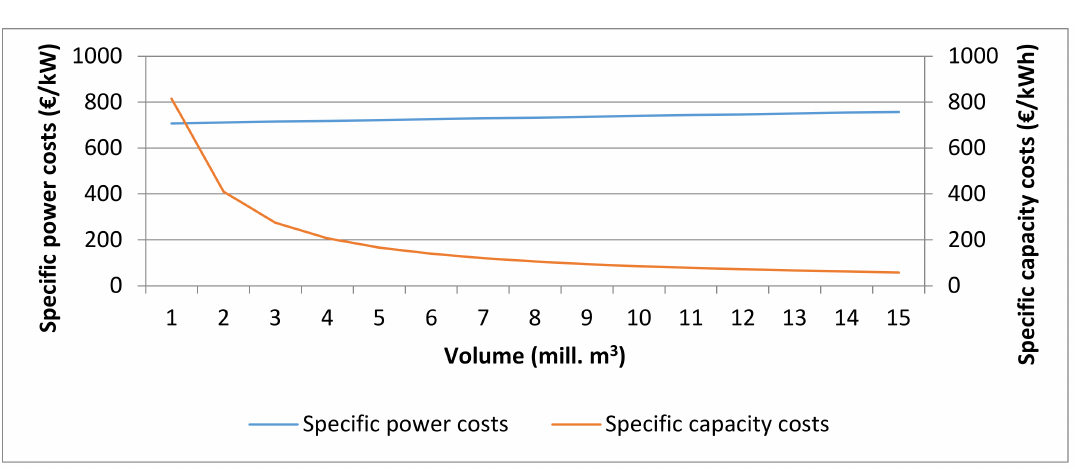
Figure 5. Specific investment costs as a function of storage volume, both in terms of installed power ( € / kW) and installed capacity ( € /